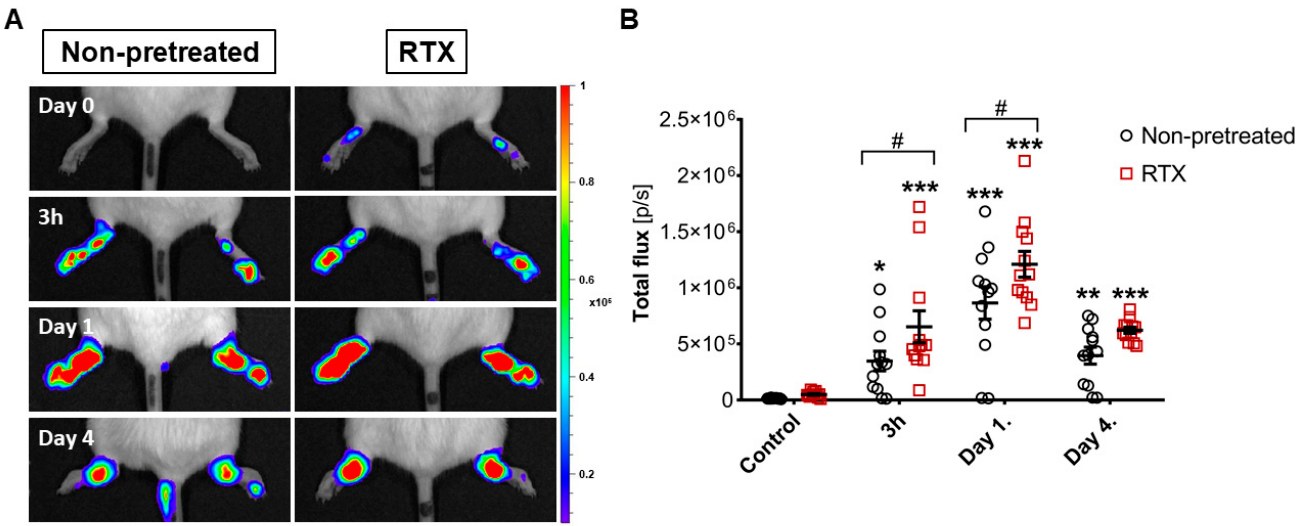
Figure 4. Inflammatory reactive oxygen species production of leukocytes assessed by in vivo luminescence imaging and the free radical sensor L-012. ( A ) Representative images and ( B ) Luminescence signal of the ankle joints. Individual values, means, ± SEM, two-way ANOVA and Fishers LSD test, n = 6/group, both limbs. * p < 0.05, ** p < 0.01, *** p < 0.001 vs. self-control values before arthritis induction, # p < 0.05 vs. non-pretreated arthritic